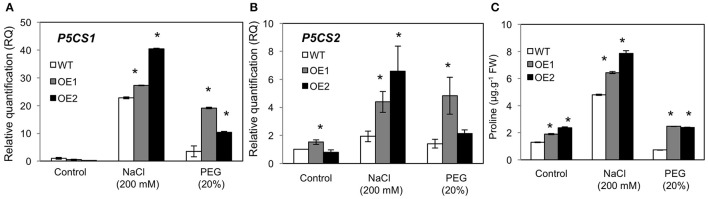
Analysis of P5CS1 and P5CS2 gene expression and proline levels in HvPIP2;5 overexpressing lines under salt and osmotic stresses. The expression levels of (A,B)
P5CS1 and P5CS2 in WT and OE lines were estimated by quantitative real time PCR. Arabidopsis clatharin gene was used as an internal control for normalization. The expression levels of each gene in WT control (calibrator) were assumed as 1. Three biological replicates were averaged and bars indicate standard error. (C) Proline contents in WT and OE were quantified with three biological replicates. Bars indicate standard error and significant differences between WT and OE lines were marked with asterisks (P < 0.05).